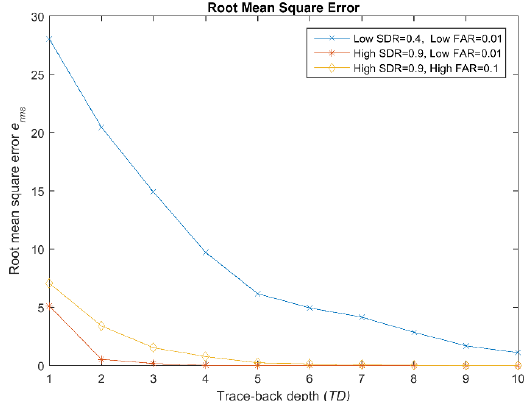
Figure 3. Root-mean-square error e rms as a function of the trace-back depth (TD), i.e., the number of recent observations received.